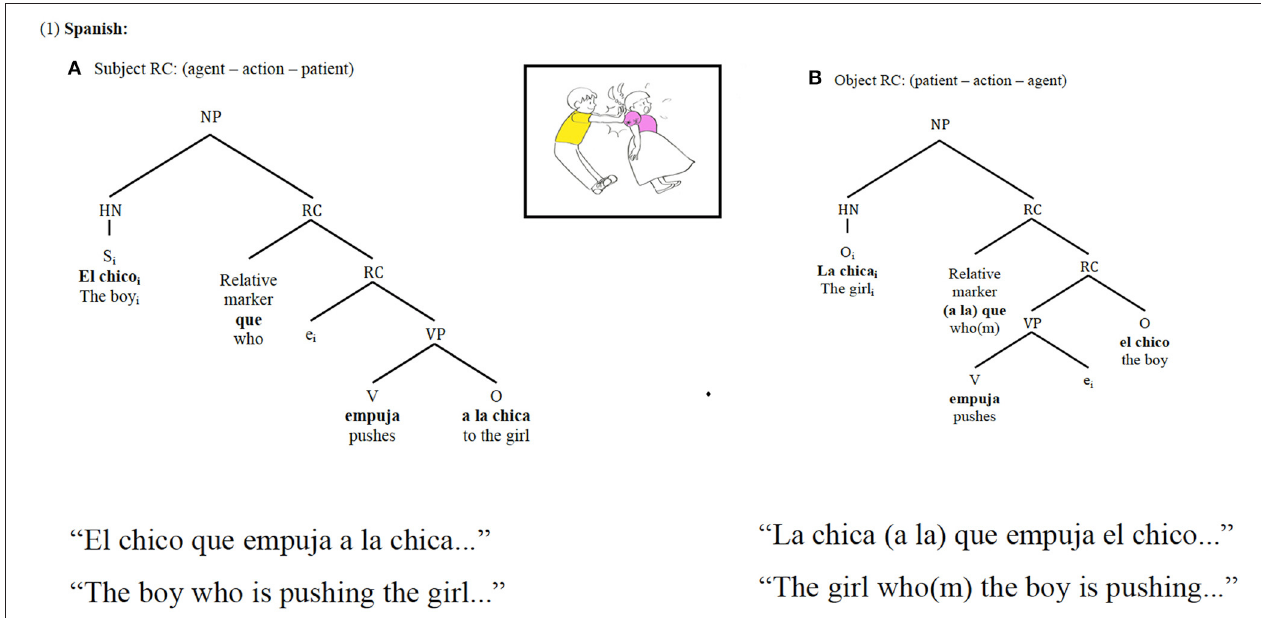
FIGURE 1 | Spanish subject RCs (A) and object RCs (B) syntactic and thematic role relations and constituent order.